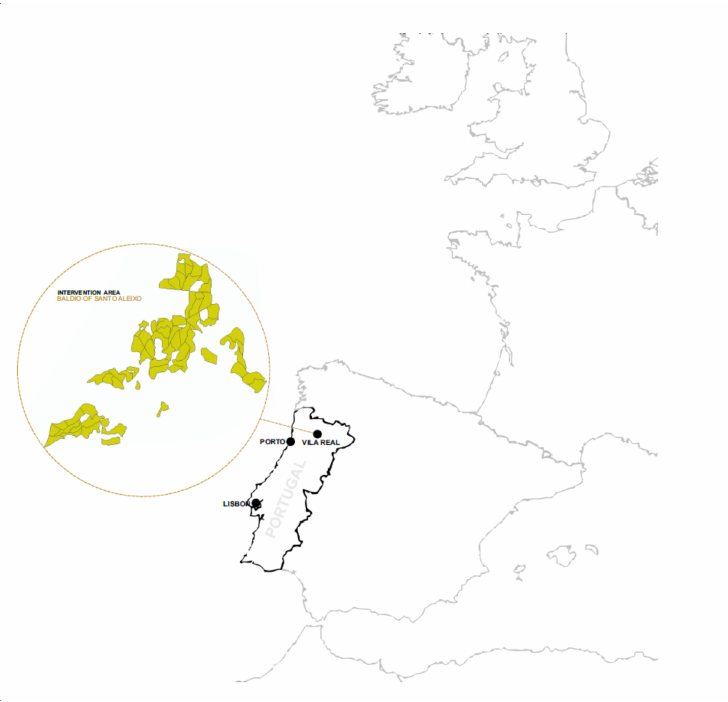
Figure 1. Geographical location of the study area. Table 1. Summary characteristics of the main variables collected in the studied stands of maritime pine (65